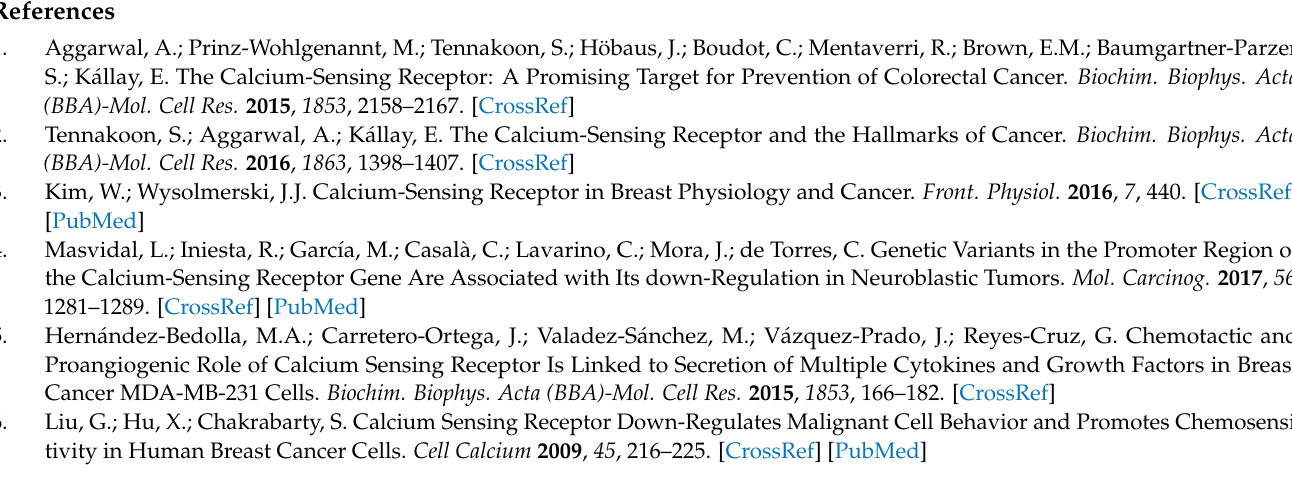
intact parathyroid hormone and primary cancer diagnosis at various pathological sites. Table S6: As- sociation of circulating calcium, vitamin D, and parathyroid hormone with secondary malignancies. Table S7: Associating of calcium, vitamin D, and parathyroid hormone levels with polymorphisms at rs1801725 and rs1801726 in individuals of European descent. Table S8: Associating of calcium, vitamin D, and parathyroid hormone levels with polymorphisms at rs1801725 and rs1801726 in individuals of African descent. Table S9: Relationship between CaSR SNPs and circulating calcium, vitamin D, and parathyroid hormone levels. Table S10: Relationship between circulating calcium, vitamin D, and parathyroid hormone levels in CaSR rs1801725 allele carriers before and after cancer diagnosis. Table S11: Association of CaSR SNPs with secondary malignancies in European descent individuals—Additive regression analysis. Table S12: Association of CaSR SNPs with secondary malignancies in European descent individuals—Recessive regression